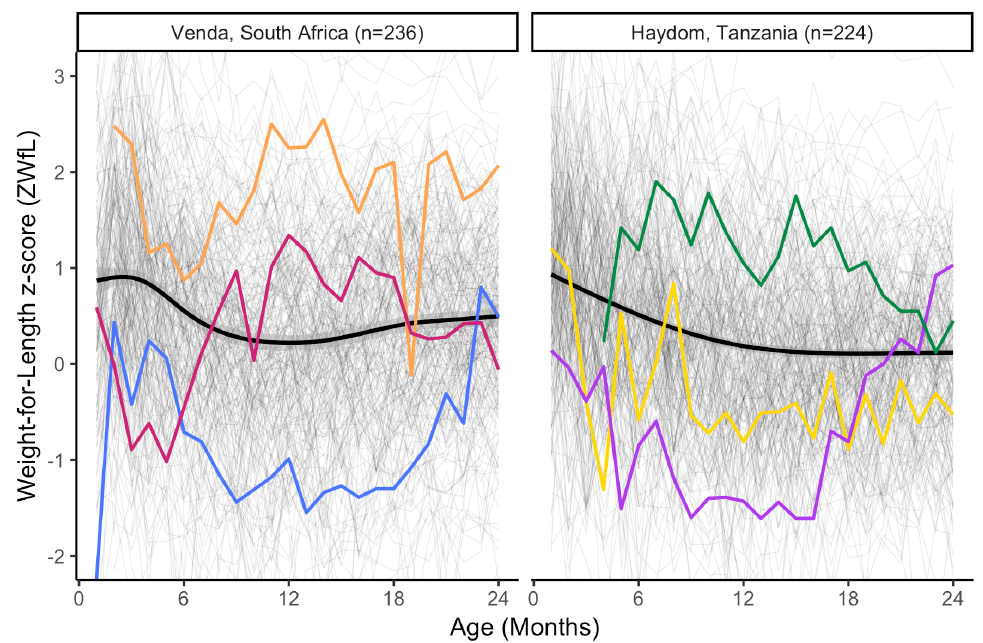
Figure 1. Observed weight-for-length trajectories for children from Venda and Haydom, 0–24 months, each thin grey line is an individual child and the thick black line is the population mean. Large within and between child variability is clear, with three random children highlighted in each